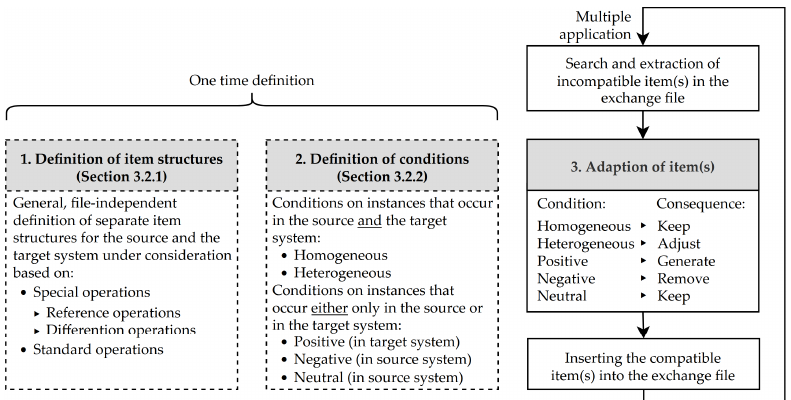
Figure 6. Key findings of the item adaption.